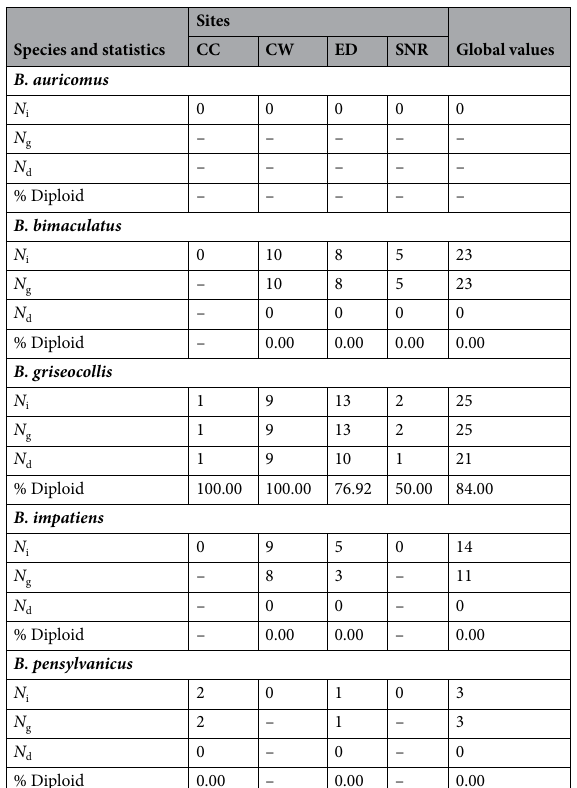
Table 2. Sample sizes and diploidy of male bumble bees ( Bombus spp.) in the greater Saint Louis region in 2018. N i is the total number of sampled males, N g is the number of successfully genotyped males, N d is the number of diploid males (i.e., number of males with ≥ 3 heterozygous loci). Percent diploid males is N d / N g . Each value is calculated per species by site and globally (i.e., combining all sites). CC Calvary Cemetery, CW Castlewood State Park, ED EarthDance Farms, SNR Shaw Nature Reserve.